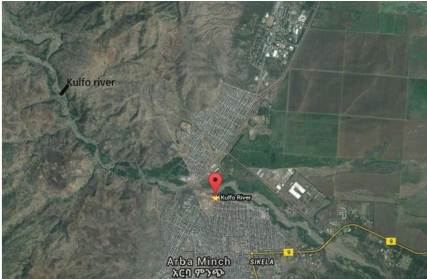
Figure 4: Google satellite map image of the site.